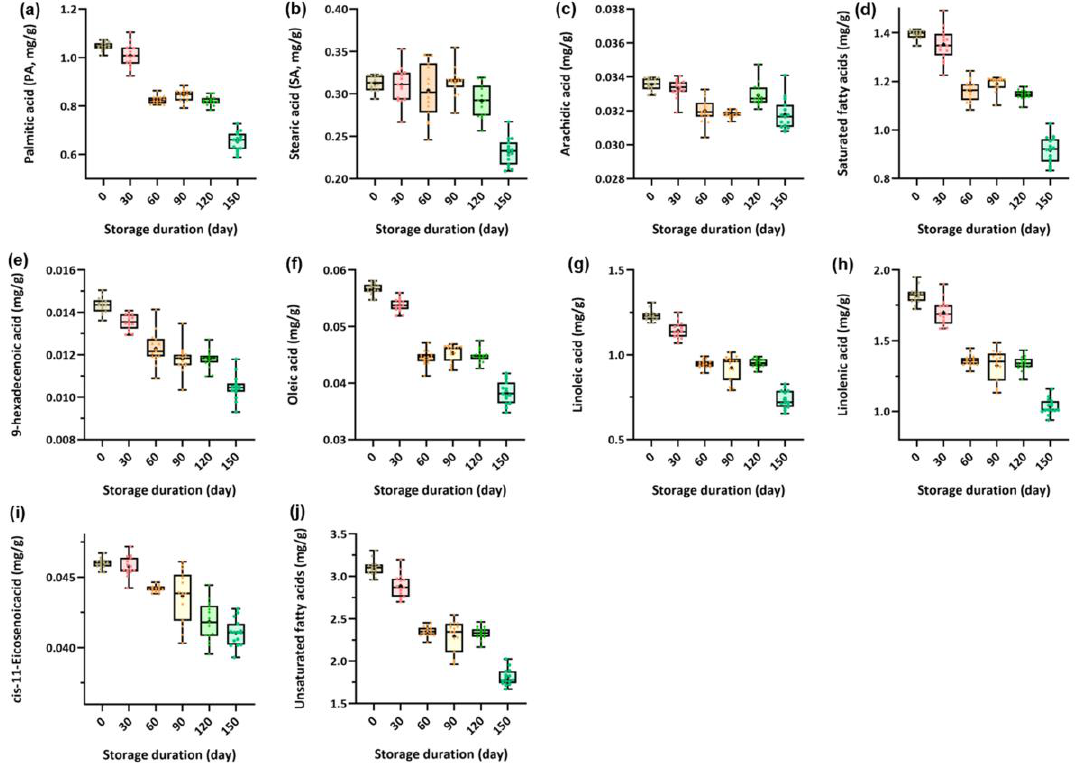
Figure 1. Measured fatty acids of tea samples with different storage duration. The boxes are bounded by the 25% and 75% quartiles, with the median values inside, whereas the extreme levels correspond to 5% and 95% quartiles. (a) palmitic acid; (b) stearic acid; (c) arachidic acid; (d) total saturated fatty acids; (e) 9-hexadecenoic acid; (f) oleic acid; (g) linoleic acid; (h) linolenic acid; (i) cis-11-eicosenoic acid; and (j) total unsaturated fatty acids. Different colors represent tea samples with different storage duration.